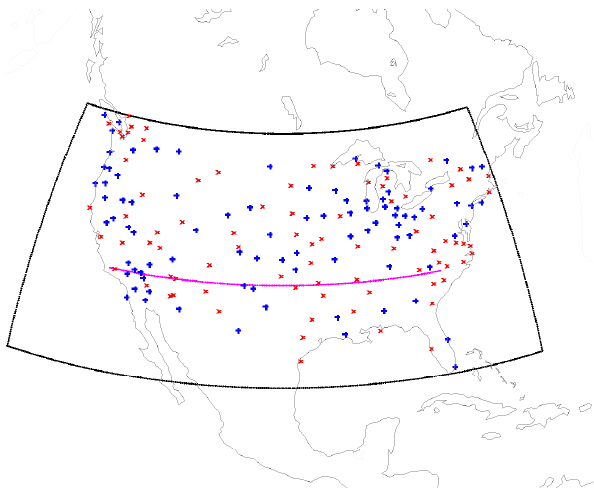
Fig. 3. Locations of IGS 1 receivers used in training (blue “+”) and Fig. 33. Locations of IGSreceivers usedintraining (blue“+”) and evaluation (red “x”); the tomographic reconstruction is delimited evaluation (red “x”); the tomographic reconstruction is delimited by the black box, and the comparison with SAMI2 output is along by the black box, and the comparison with SAMI2 output is along the central magenta line. the central magenta